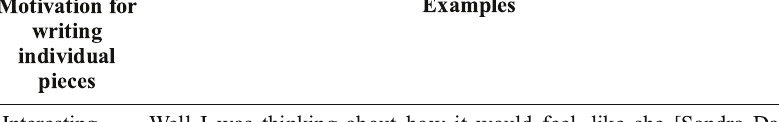
Code Examples: Cross-setting Motivations to Write Individual